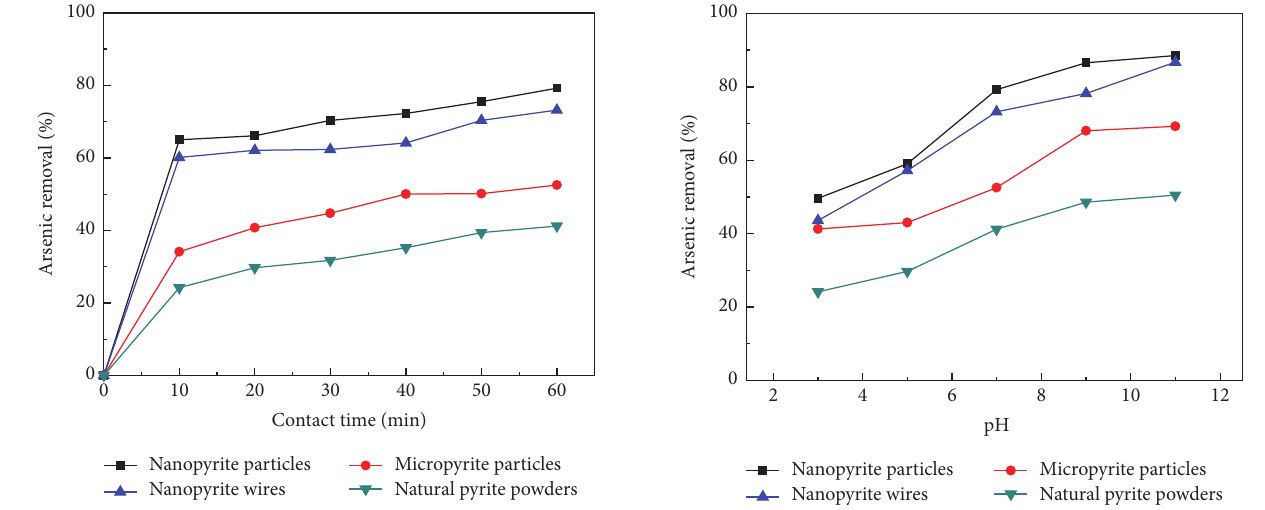
Figure5:EffectofpHonsorptionofarsenic(contacttime=60 min, initial arsenic concentration = 30mgL −1